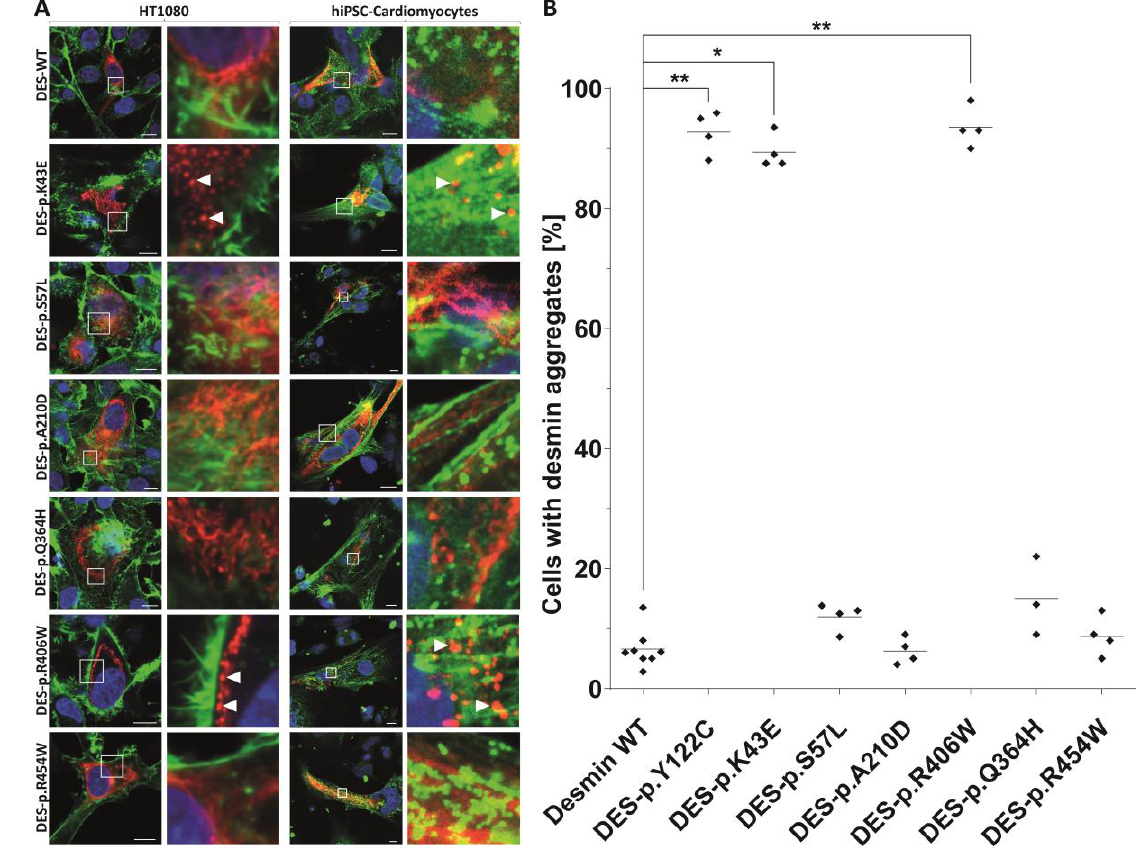
Figure 2. Cell transfection experiments of transfected HT1080 cells and iPSC-derived cardiomyocytes. Mutant and wild-type desmin was expressed with the red fluorescent protein-tag mRuby at the C-terminus (shown in red). Representative confocal images are shown ( A ). In case of HT1080 cells, F-actin was stained using phalloidin-Alexa488 (shown in green) and the nuclei were stained using 4′,6 -diamidin-2-phenylindole (shown in blue). In case of iPSC-cardiomyocytes, the cardiomyocyte marker α -actinin was stained using antibodies (shown in green) and the nuclei were stained with DAPI (shown in blue). Scale bars represent 10 µm. (B) Quantification of aggregate formation was performed in three to four independent transfection experiments of HT1080 cells. * p < 0.05 and ** p < 0.01. The variant DES-p.(Y122C) was used as a positive control forming abnormal cytoplasmic aggregates [20].